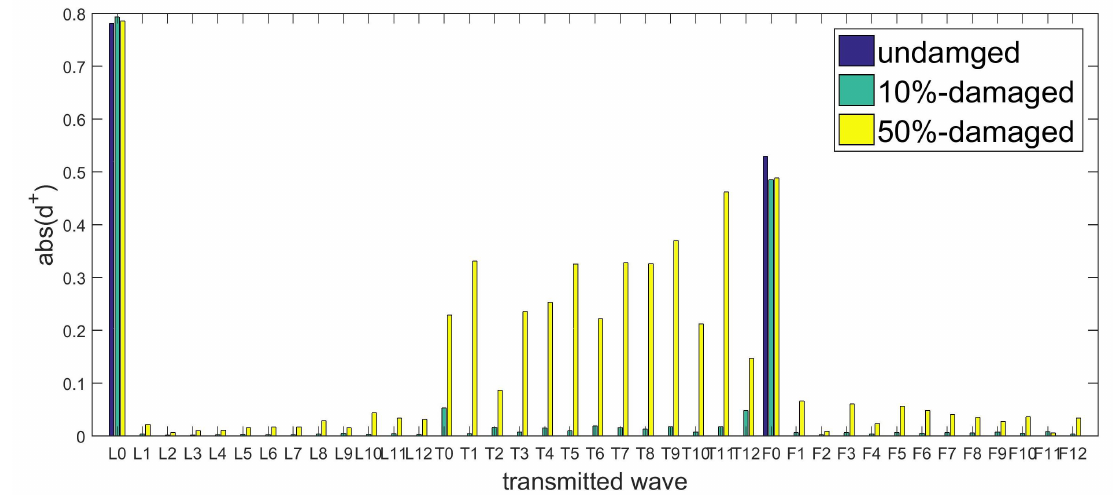
Figure 25. WFEM results: transmitted wave amplitudes of couple element excited by L 0